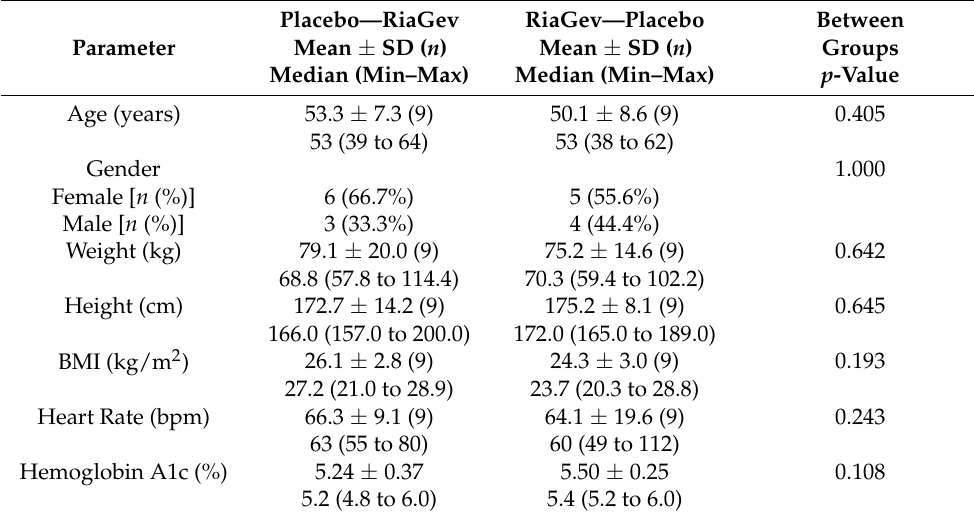
Table 1. Subjects Demographics and Grouping. The subjects were randomized and divided into two matching groups based on their demographic and physical information, such as age, sex, weight, and height. The BMI, heart rate, and hemoglobin A1c of each group were also not statistically different. The clinical trial of each group proceeded with either Placebo-RiaGev sequence or RiaGev-Placebo sequence in cross-over design (Figure